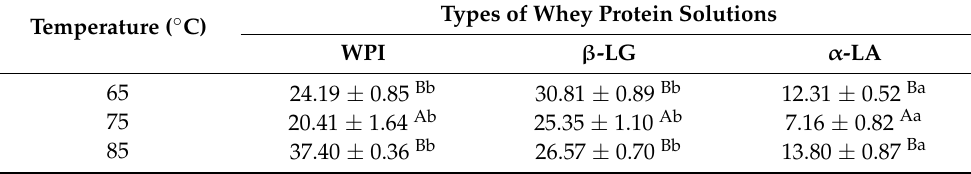
Data are presented as mean ± standard deviation ( n = 3). The different letters A,B in the same column indicate a significant difference at p < 0.05. The different letters a,b in the same row indicate a significant difference at p < 0.05.